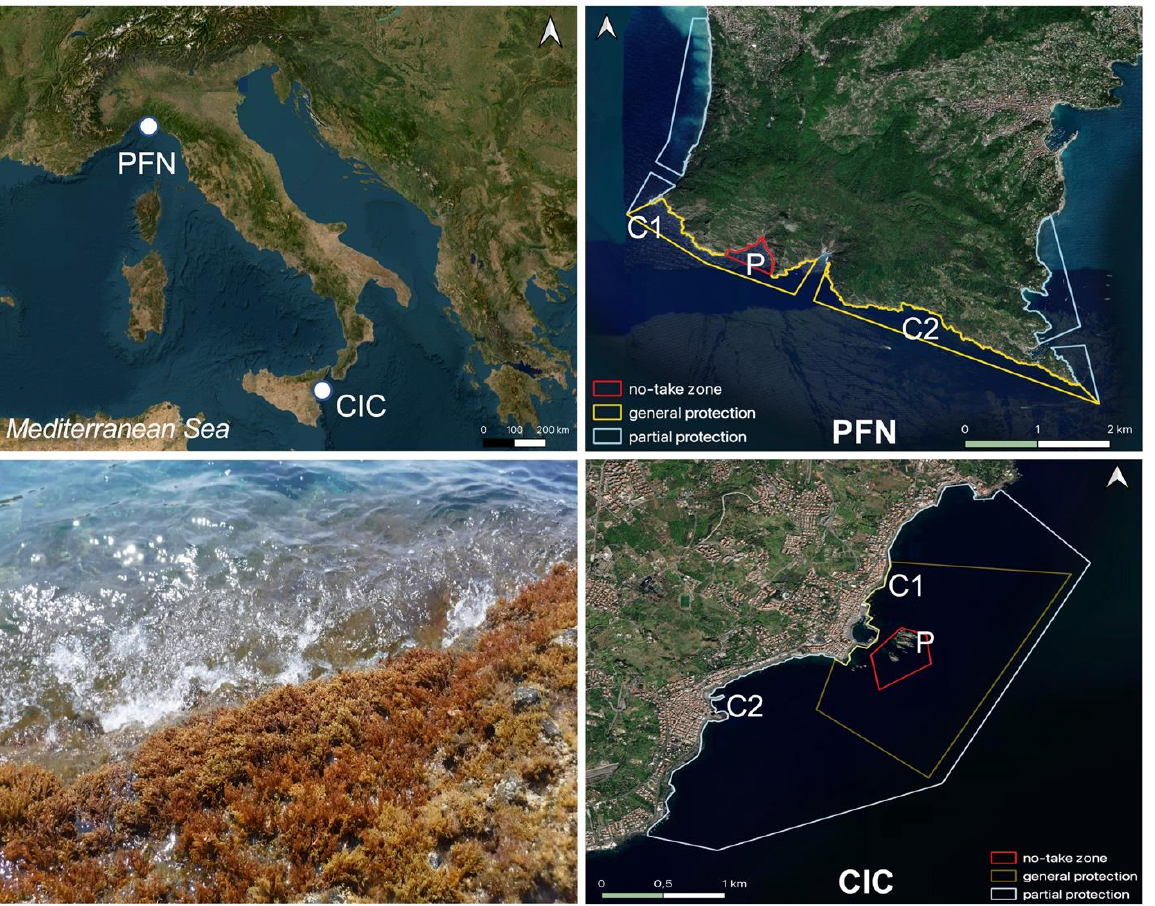
Figure 1. Study areas (the MPAs of Portofino, PFN, and Isole Ciclopi, CIC) and sampling sites. P = no-take, no-access area; C1 = control site 1; C2 = control site 2. Limits of zones under different protection regimes within the MPAs were also reported. Example of E. amentacea midlittoral fringe at PFN (bottom left corner).